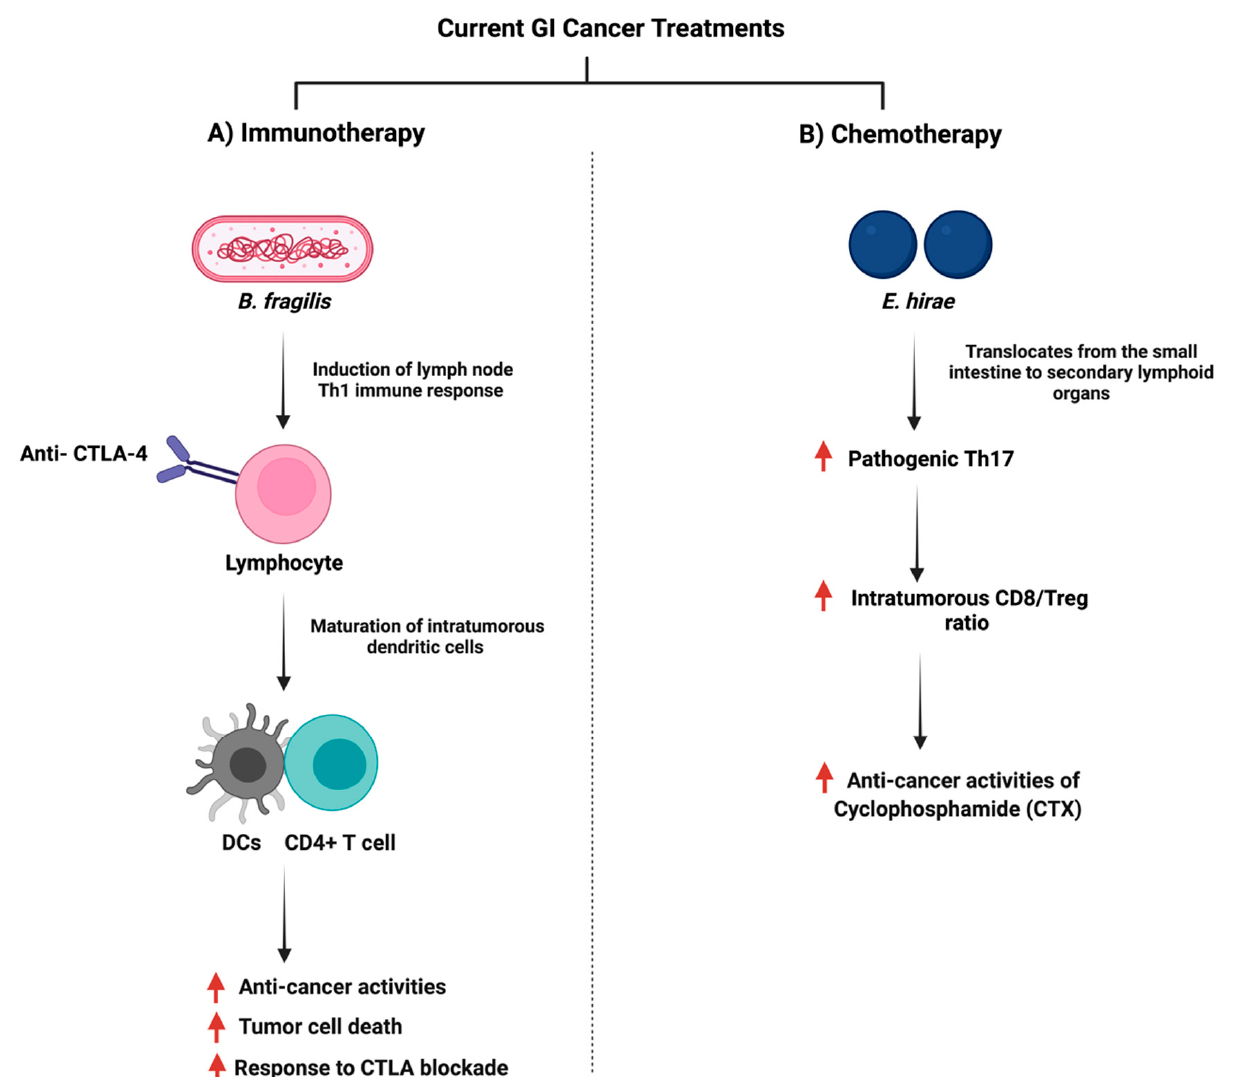
Figure 7. Illustrations of the gut bacteria and their role in modulating the efficacy of the currently used anti-cancer drugs. The figure summarizes the influence of the reported bacteria on immunotherapy and chemotherapy treatments. “Created with BioRender.com”.